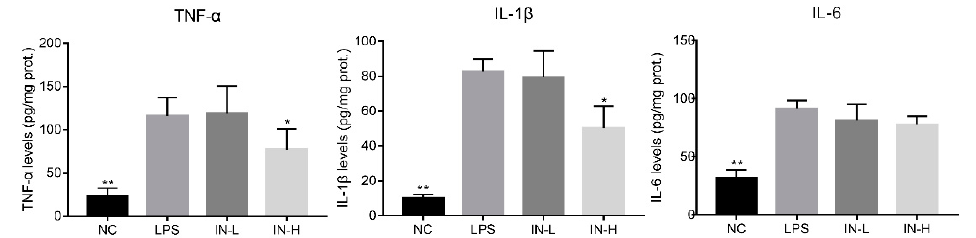
Figure 2. Effects of inosine pretreatment on the levels of TNF- α , IL-1 β , and IL-6 in mice treated with LPS. * p < 0.05; ** p < 0.01, relative to the LPS group. LPS. * p < 0.05; ** p < 0.01, relative to the LPS